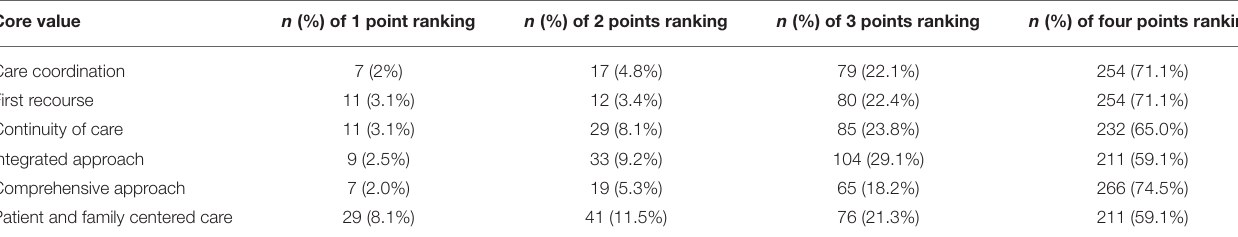
TABLE 3 | The CV ranking.